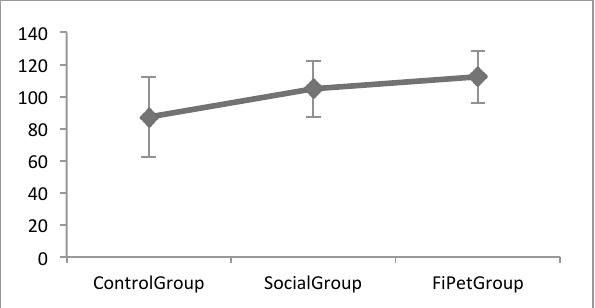
Figure 9. Goal Completeness: the Percentages of the Three Study Conditions